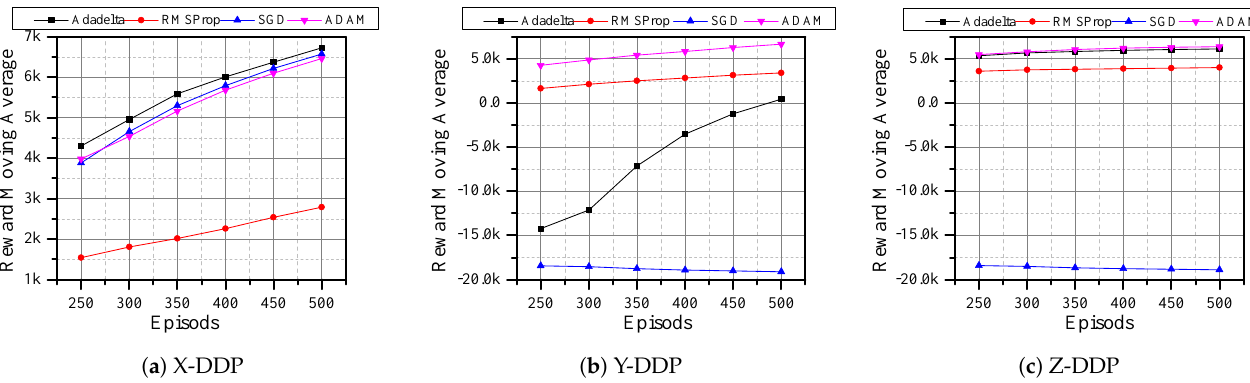
Figure 6. DQN and different optimizers with 100 steps/episode for a total of 500 episodes using the Euclidean distance reward